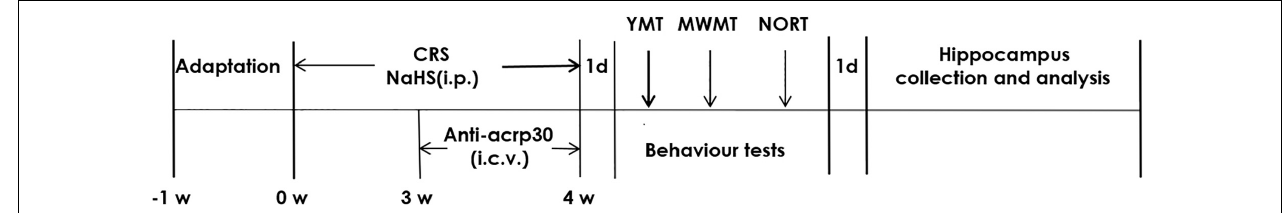
FIGURE 1 | Schematic diagram of the experimental procedures. CRS, chronic restraint stress; YMT, Y-maze test; MWMT, Morris water maze test; NORT, novel object recognition test; i.p., intraperitoneal injection; i.c.v., intracerebroventricular